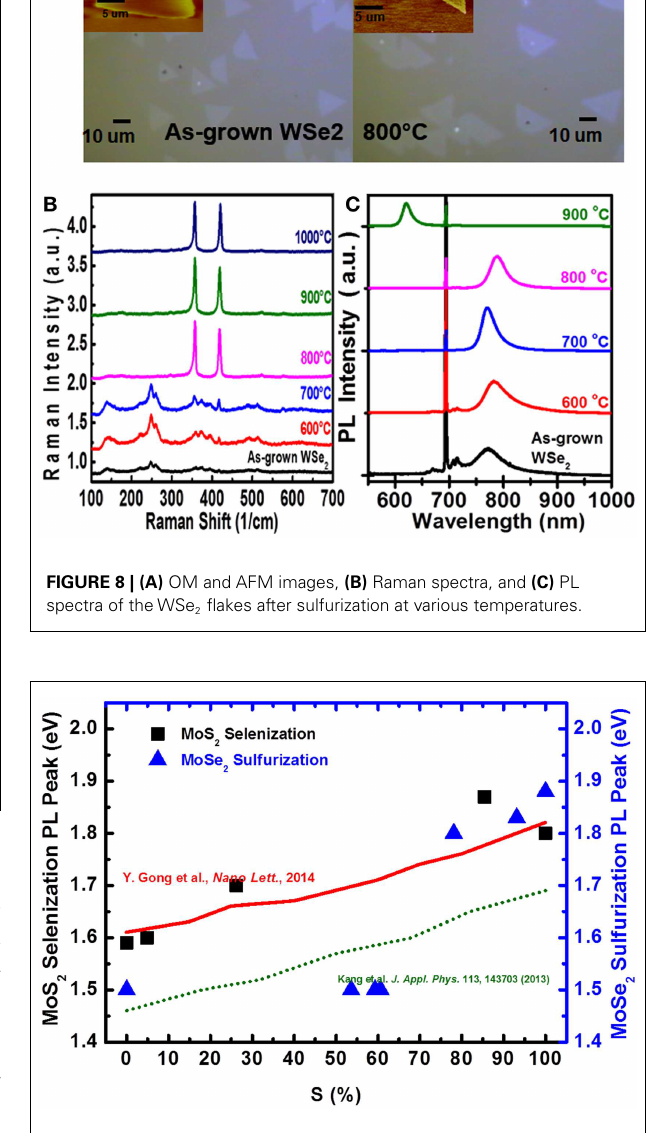
that the experimental optical band gap is larger than the calcu- lated gap. Most importantly, the conversion is governed by the selenization temperature, indicating that the process is thermo- dynamically controlled. However, due to the presence of biphase domains, the PL peak position vs. S% for MoSe 2 sulfurization exhibits distinctly different behavior compared to that for MoS 2